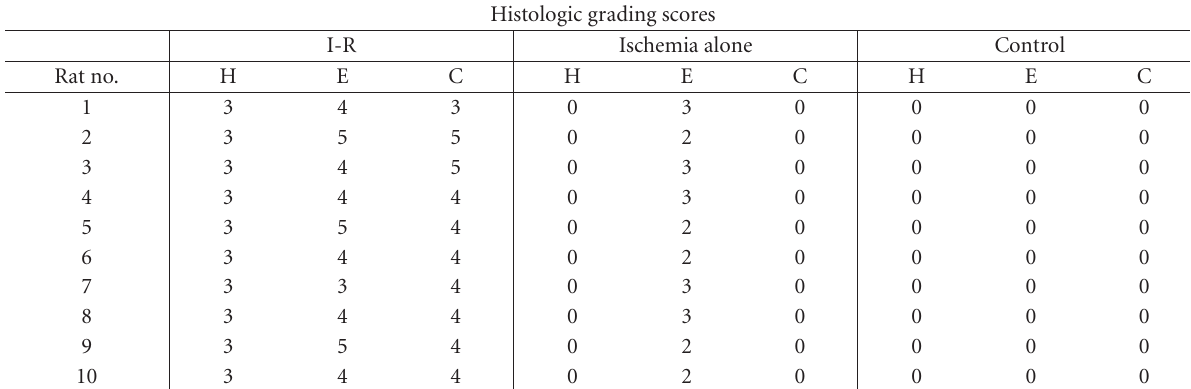
Table 3. Histologic grading results are seen for each rat within groups; H = hemorrhagia, E = edema, C = congestion; Isc = ischemia- only group, I-R = ischemia-reperfusion. Histologic grading scores I-R Ischemia alone Control Rat